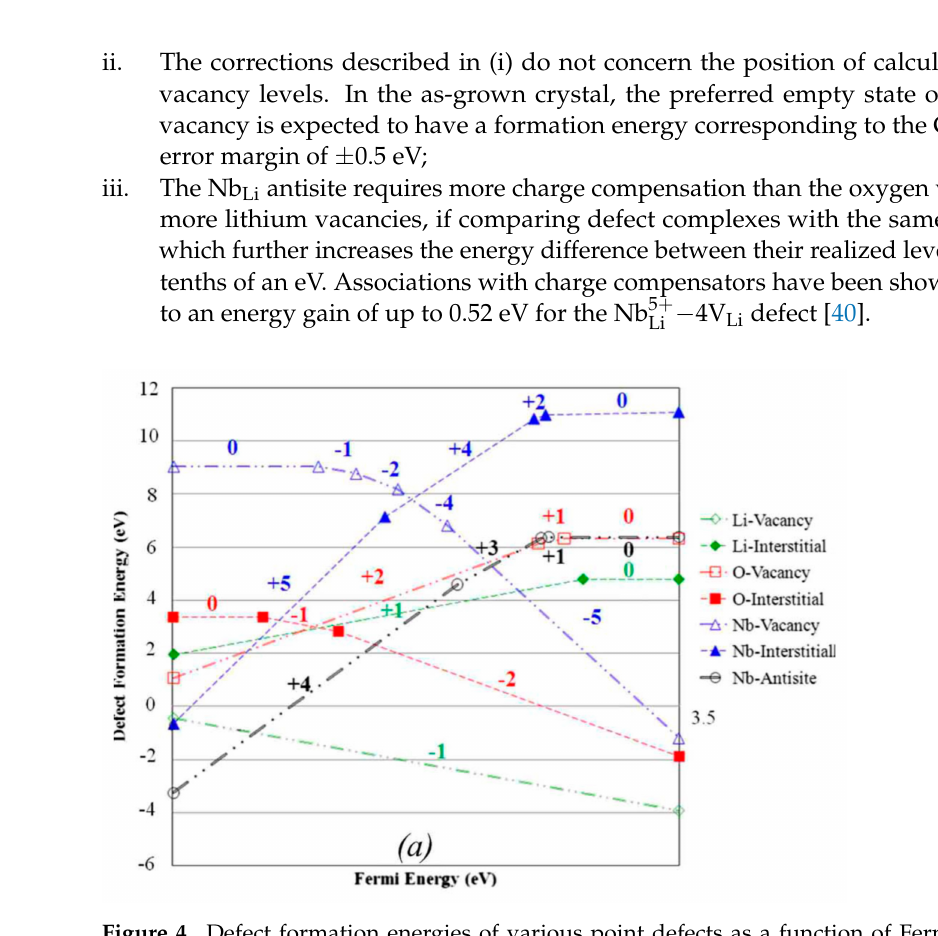
Figure 4. Defect formation energies of various point defects as a function of Fermi energy; the lowest-energy net charge state is given in each case. The Fermi energy ranges from ε F = 0 (left) at the VBM to ε F = 3.5 eV (right) at the CBM (without self-interaction correction and charge compensation, Reprinted with the permission from Ref [13]. Copyright 2021 American Physical